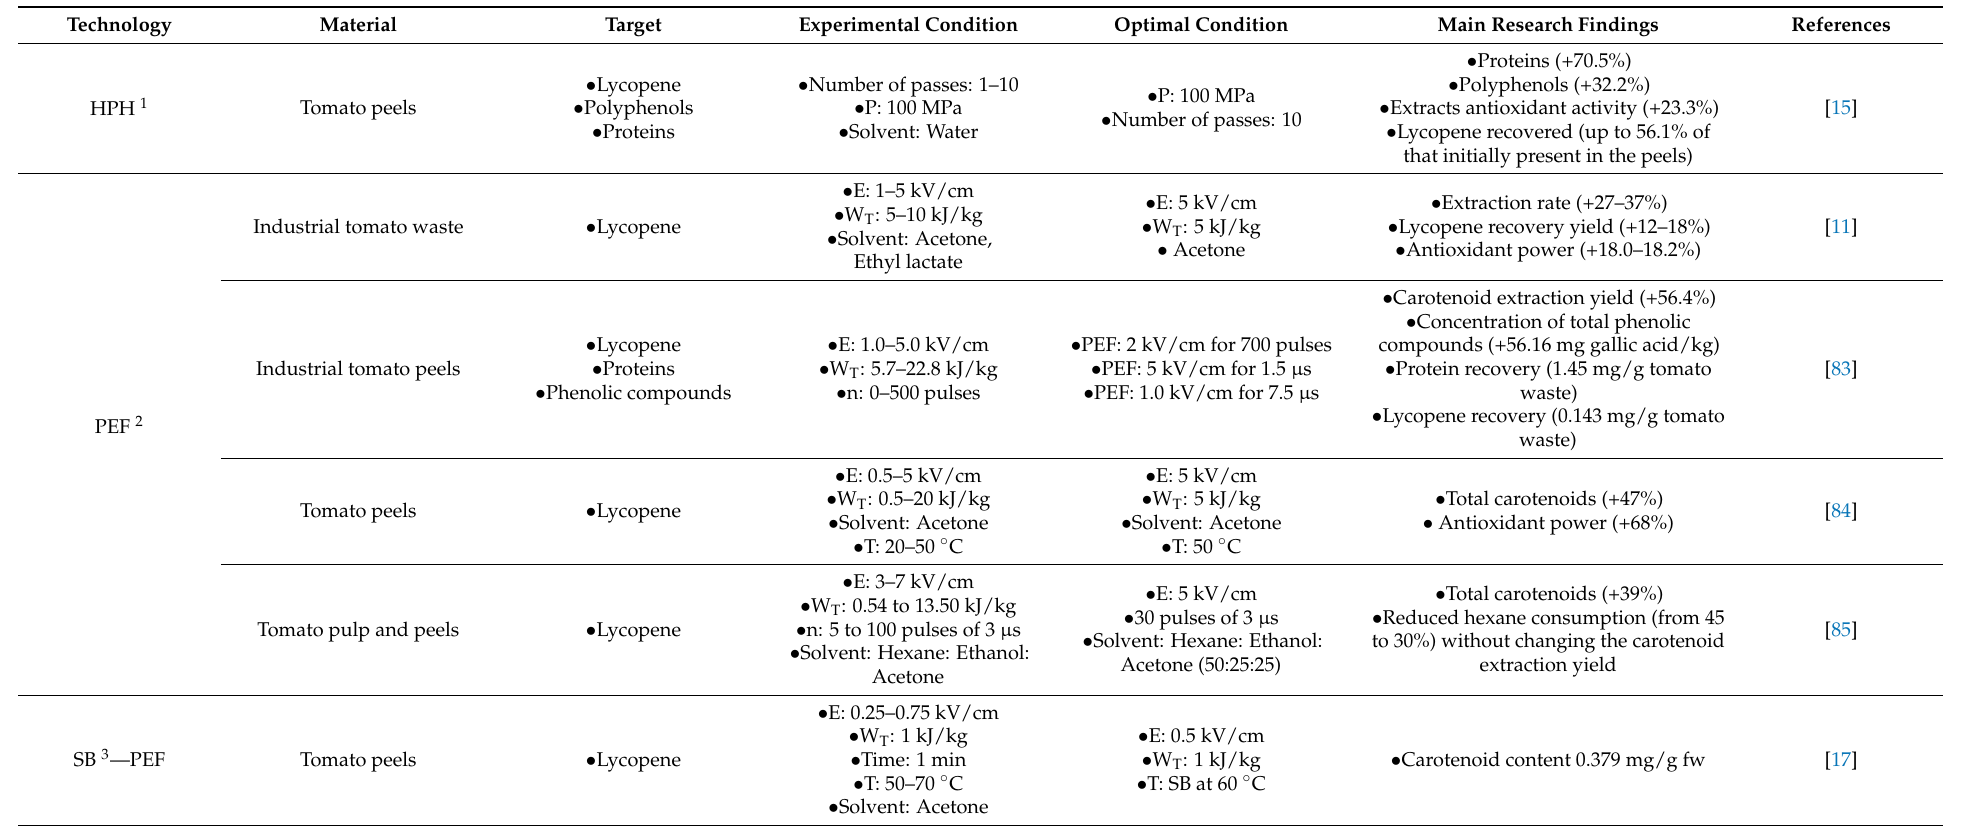
Table 3. Emerging technologies used for bioactive compound extraction from tomato processing by-products, type of biomass, target functional compounds recovered, experimental conditions, and main research